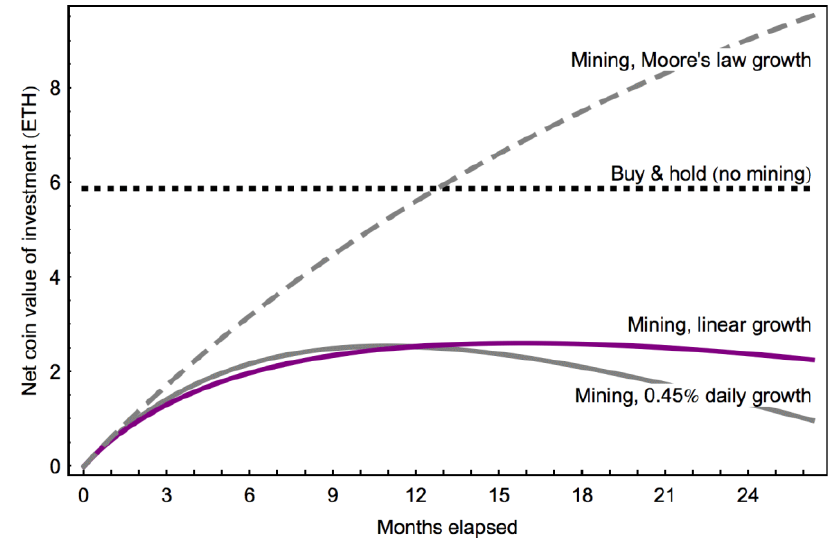
Fig. 1. Accumulated daily cash flow for four investment scenarios at 0.19€ per kW-hr (Amsterdam prices). At estimated global hashing capacity growth (0.45% per day), the max NCV for mining occurs after 1 year and underperforms the buy-and-hold strategy by more than